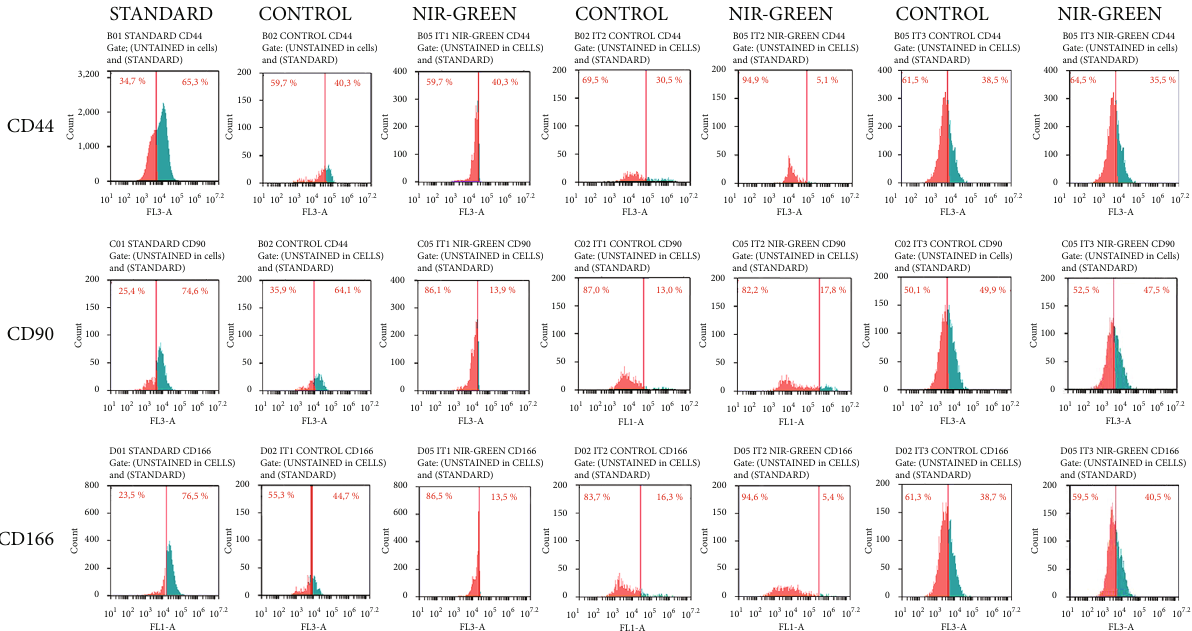
Figure 1: Characterization of di ff erentiated iADSCs using CD44, CD90, and CD166 markers. Fluorescent protein detection through fl ow cytometry. Flow cytometry analysis revealed a decrease in SC markers 7 days postlaser treatment in experimental groups. A shift to the right in distribution indicated an increase in CD marker